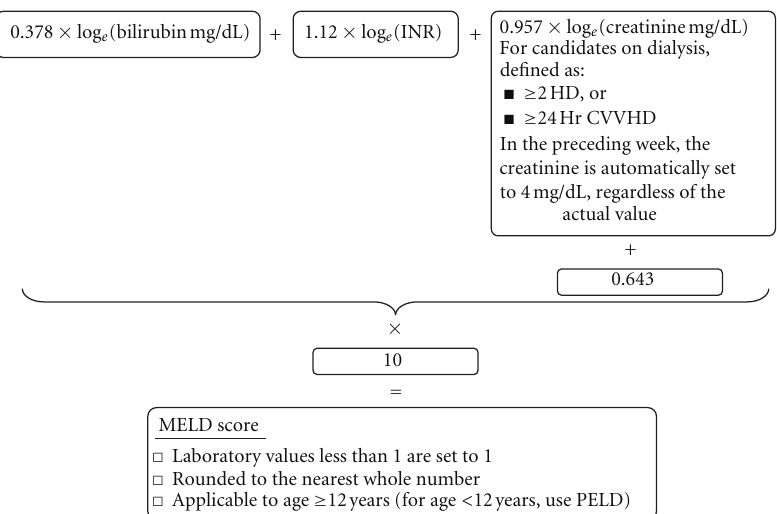
Figure 1: The UNOS modification of the MELD score, currently in use in the US for organ